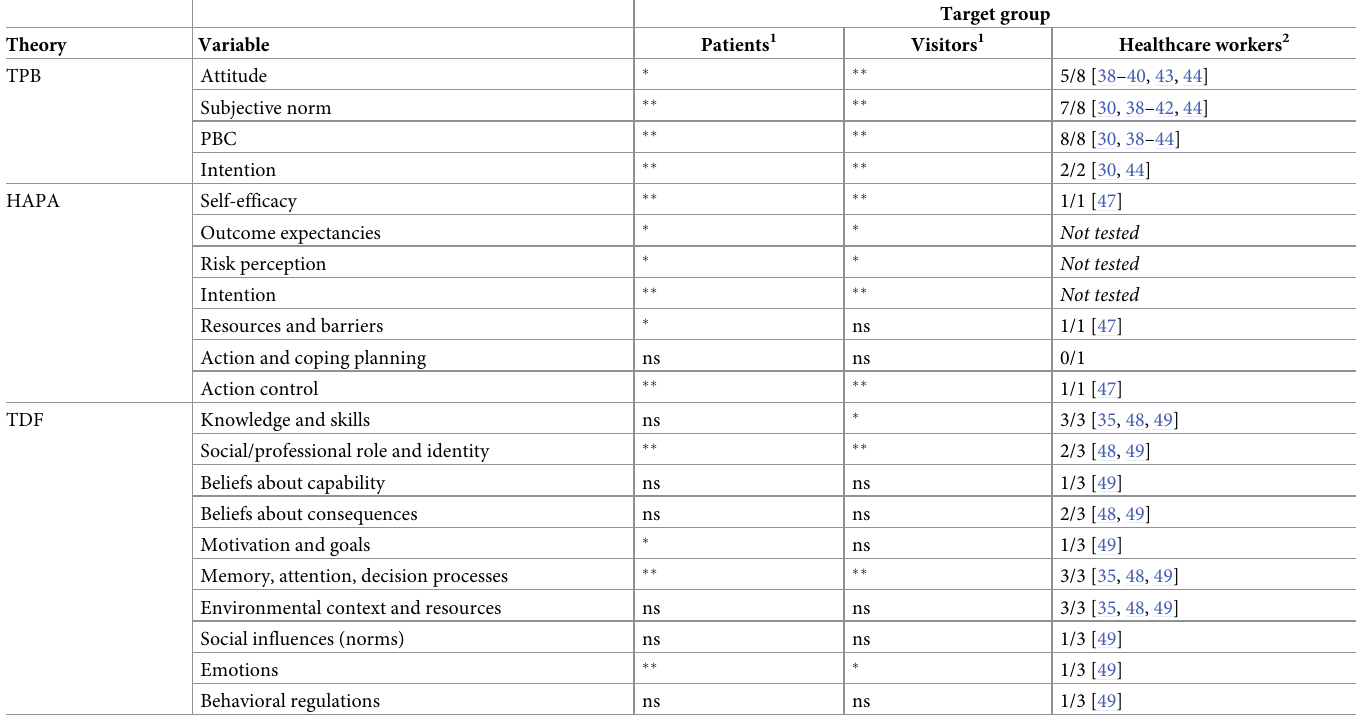
Table 5. Support for the association between individual determinants and hand hygiene